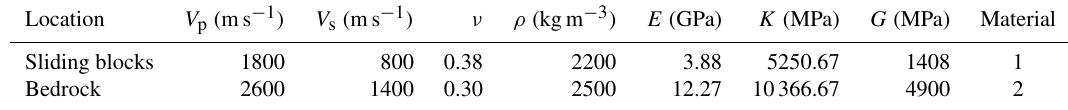
Table 1. Parameters used for the blocks properties.